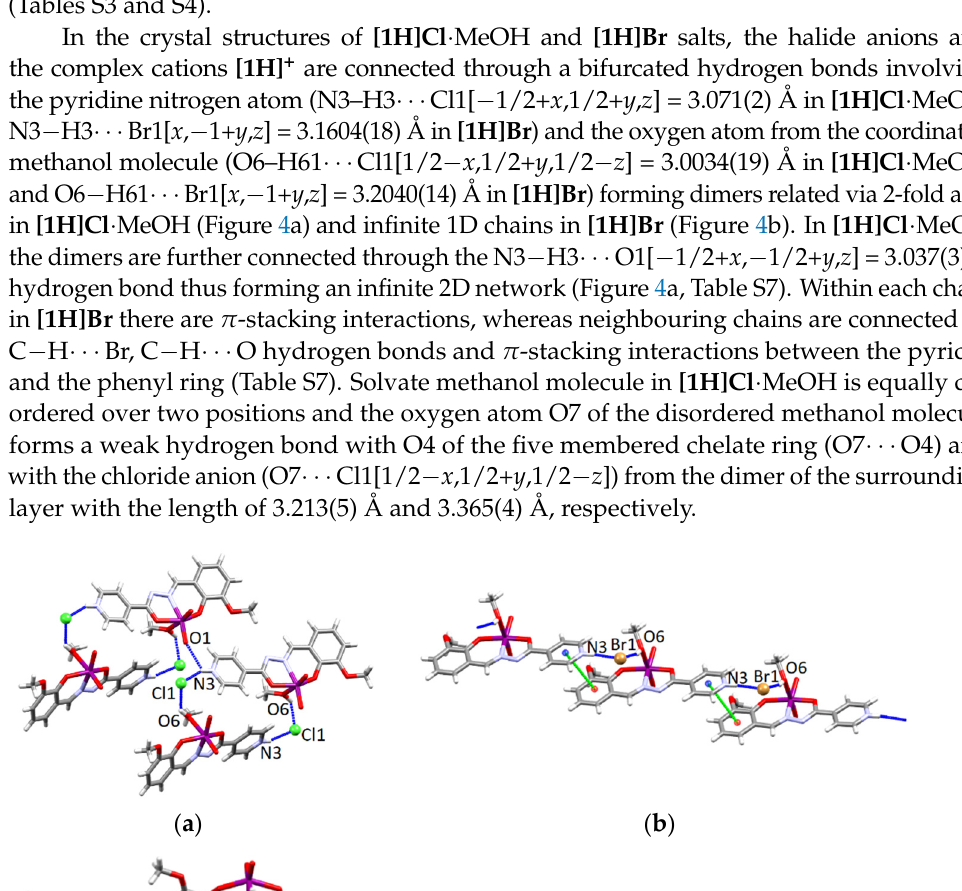
Figure 3. PXRD patterns of [MoO 2 (L)(MeOH)] polymorphs: ( top ) obtained by reaction of H 2 L with [MoO 2 (acac) 2 ], ( bottom ) obtained by sample obtained upon deprotonation of [1H]Cl ·MeOH. The orange lines indicate patterns obtained by powder diffraction, while the blue lines indicate patterns calculated from the X-ray single-crystal structures of the corresponding polymorphs.